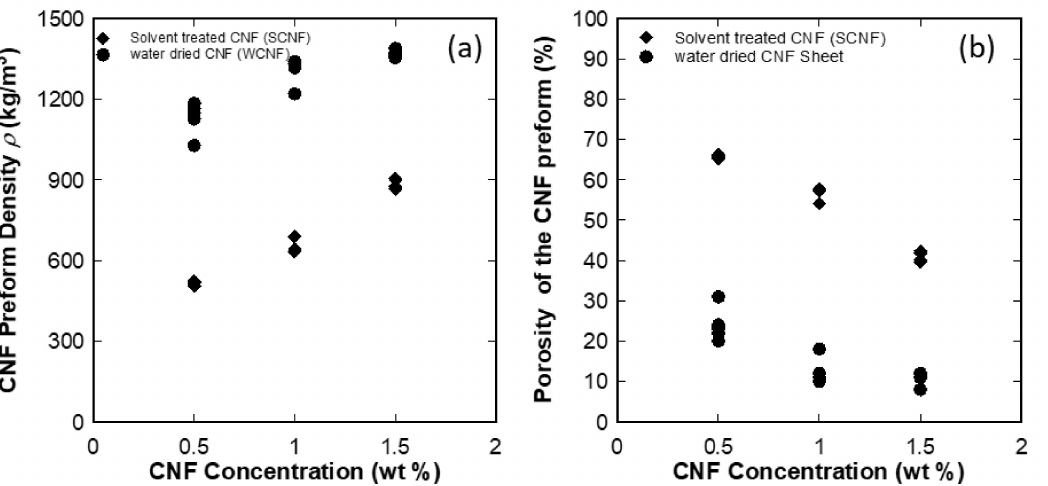
Figure 3. ( a ) Density and ( b ) porosity of the CNF preform as a function of CNF concentration in wt